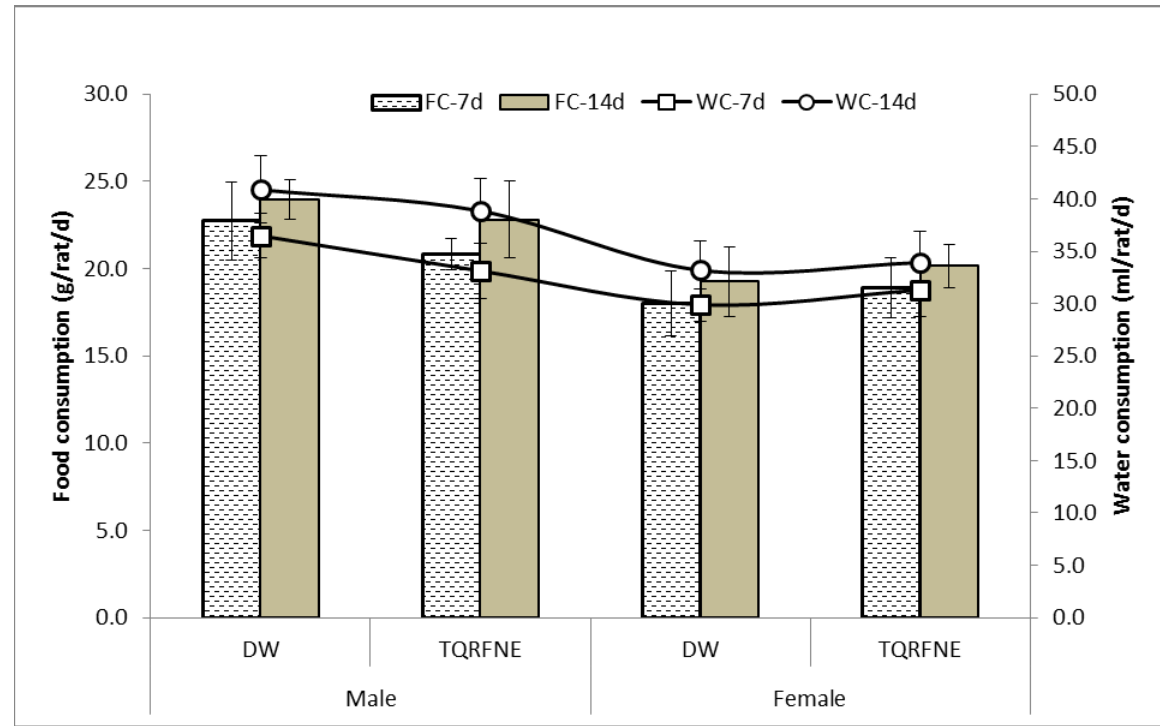
Figure 2. Effects of oral administration of thymoquinone-rich fraction nanoemulsion (TQRFNE) and distilled water (DW) on daily food (g/rat/d) and water (ml/rat/d) consumption of male and female rats (n = 5). Values are expressed as mean ± SD. P values < 0.05 were considered as significant using one way ANOVA followed by Least Significant Difference (LSD). For each gender, there was no significant difference ( p ≥ 0.05) compared to the control group (DW). FC: Food consumption, WC: Water